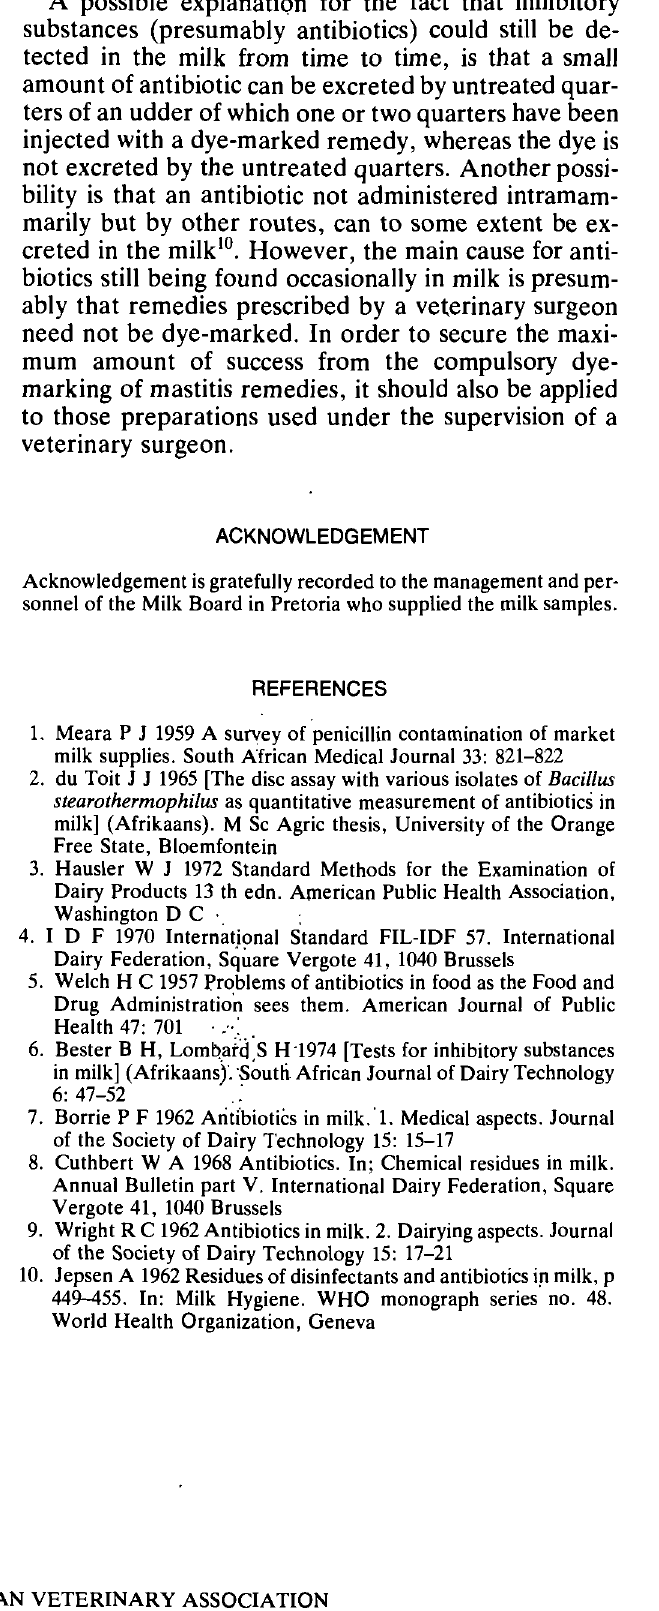
Table 4: THE INCIDENCE OF INHIBITORY SUBSTANCES IN MARKET MILK SOLD IN PRETORIA DURING THE PERIOD AUGUST 1977 TO OCTOBER 1978 Herd milks samples Penicillin equiv. No. positive % (IU/ml) 0,005 to 0,009 5 0,46 0,010 to 0,049 10 0,925 0,050 to 0,099 2 0,185 0,100 to 0,199 2 0,185 0,200 to 0,499 1 0,092 3 0,278 0,500 to 0,990 1,000 to 4,990 0 0 5,000 and more 0 0 23 0 Total Total samples 1081 tested